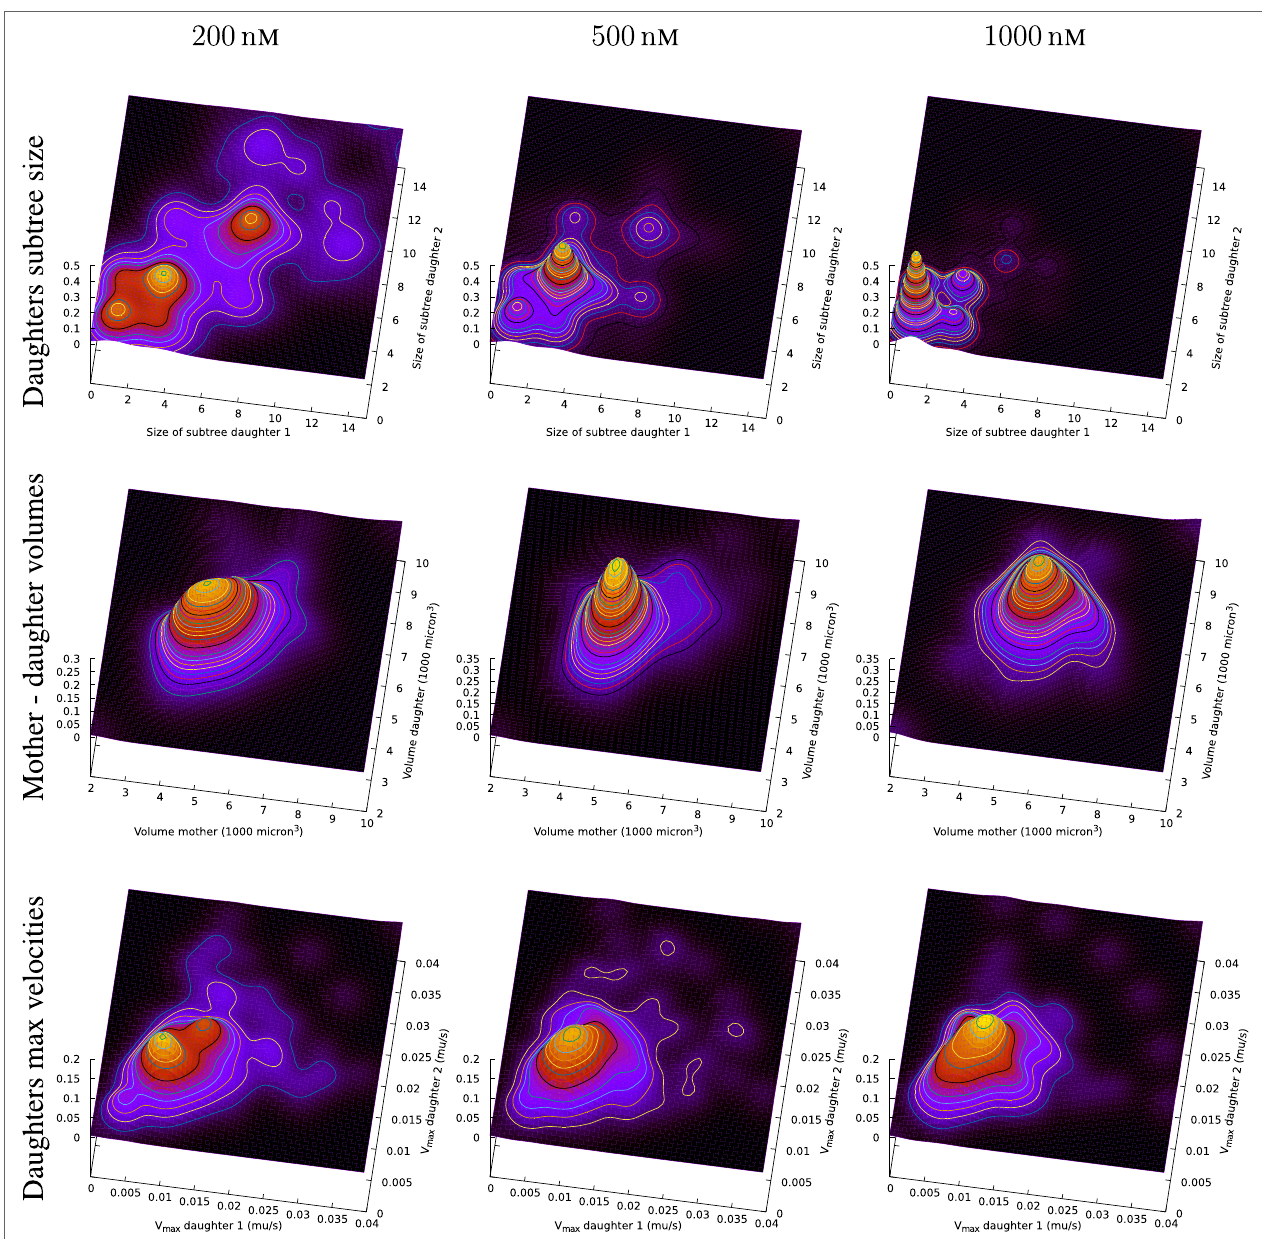
FigUre 13 | Top row: joint distribution of size of subsequent sub-trees for sister cells. The surfaces are smoothed version of normalized impulses at positions given by associated values from tuples of sister cells. Symmetry is forced by switching values for sisters (artificially doubling the number of observations). Middle row: joint distribution of volume of mother and daughter cell. Bottom row: observed maximum velocity of sister